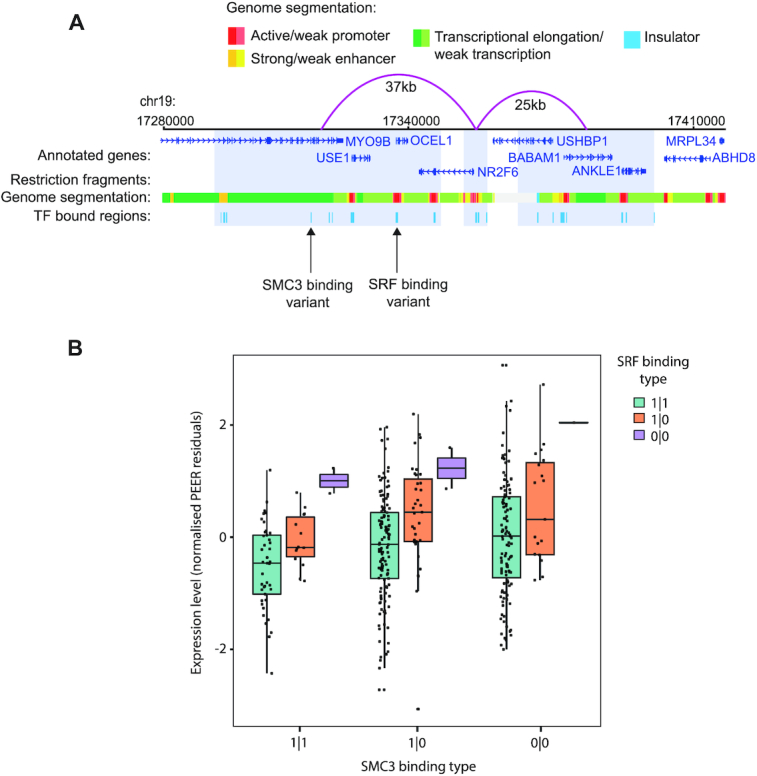
Example of a multivariant association between TF binding affinity at CRMs and their target gene expression. (A) Genome browser representation of NR2F6 promoter distal interactions (represented by pink arches) as detected by PCHi-C (49) in LCL GM12878. The genome segmentation track for GM12878 based on chromHMM (80) is shown immediately below. CRMs at the distally interacting fragments (pale blue) and NR2F6 TSS-proximal window are depicted in azure blue. The distal fragment downstream of NR2F6 contains two CRM variants: one 44 kb away from the NR2F6 promoter and the other 19 kb away, predicted to impact SMC3 and SRF binding affinity, respectively, across the 359 LCLs. (B) Association between NR2F6 mRNA levels and predicted SMC3 and SRF binding affinity haplotypes.